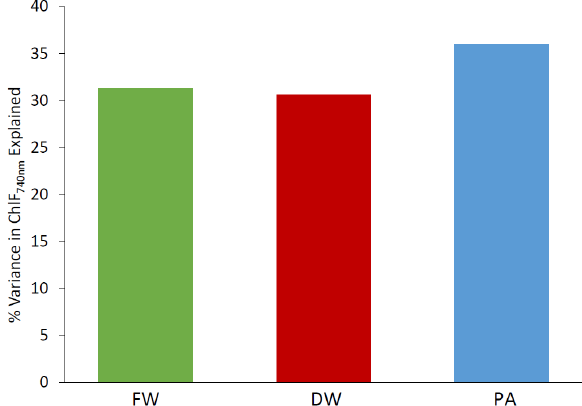
Figure 5. Percent variance in ChlF 740nm explained by fresh weight (FW), dry weight (DW) and plant area (PA) of experimental plants as determined by multiple linear regression, followed by relative importance